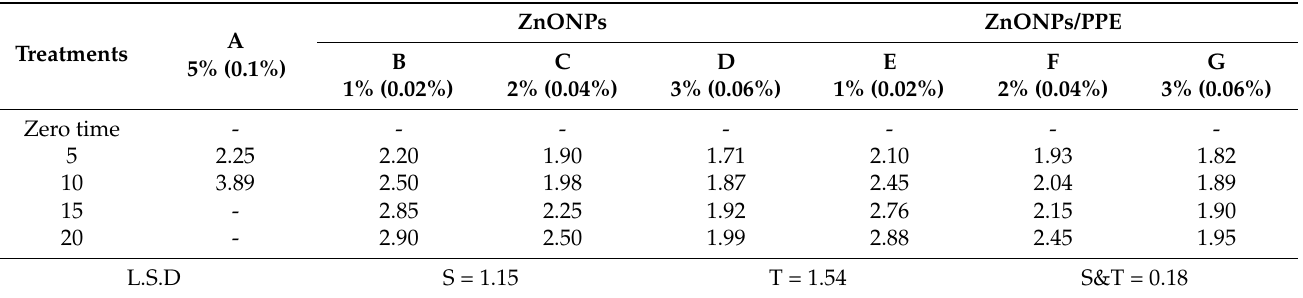
Table 6. Effect of edible film and coatings on weight loss (%) of manfalouty pomegranate during storage at 2 ◦